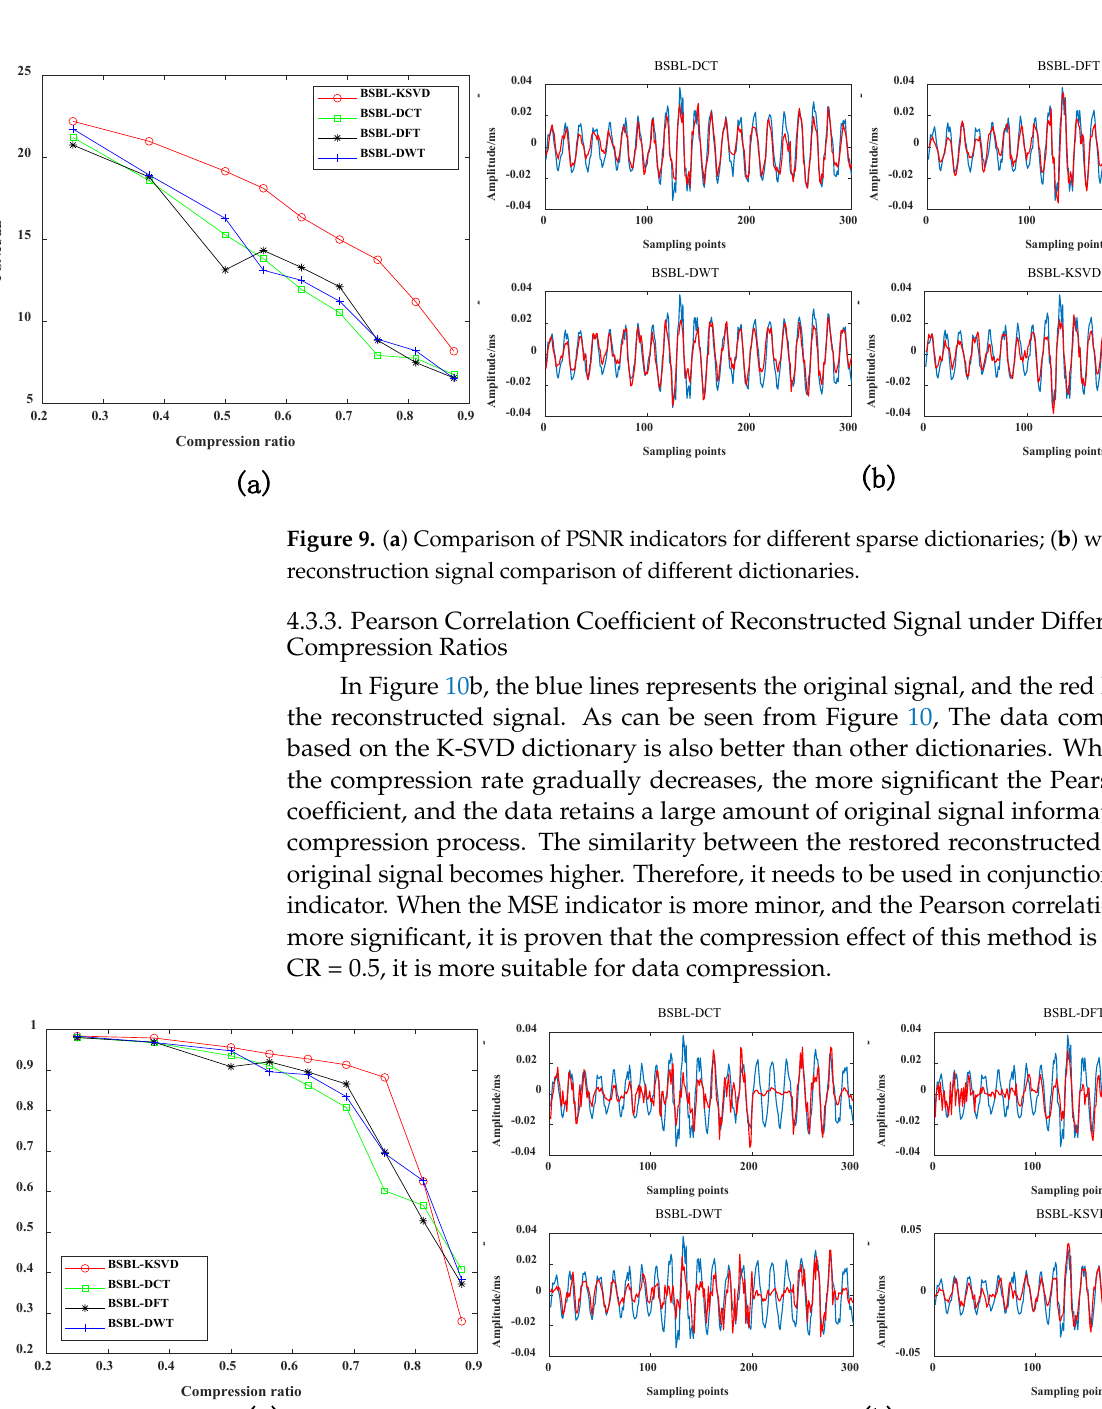
Figure 8. ( a ) Comparison of MSE indicators of different sparse dictionaries; ( b ) when CR = 0.5, the reconstruction signal comparison of different dictionaries. 4.3.2. Peak Signal-to-Noise Ratio of Reconstructed Signal under Different Compression Ratios In Figure 9b,the blue lines represents the original signal, and the red lines represents the reconstructed signal. As can be seen from Figure 9, The data compression effect based on the K-SVD dictionary is better than other dictionaries. When CR > 0.7, the PSNR indi- cator becomes smaller as the compression rate increases. It shows that a great deal of data information is lost in data compression. The recovered reconstructed signal is quite dif-